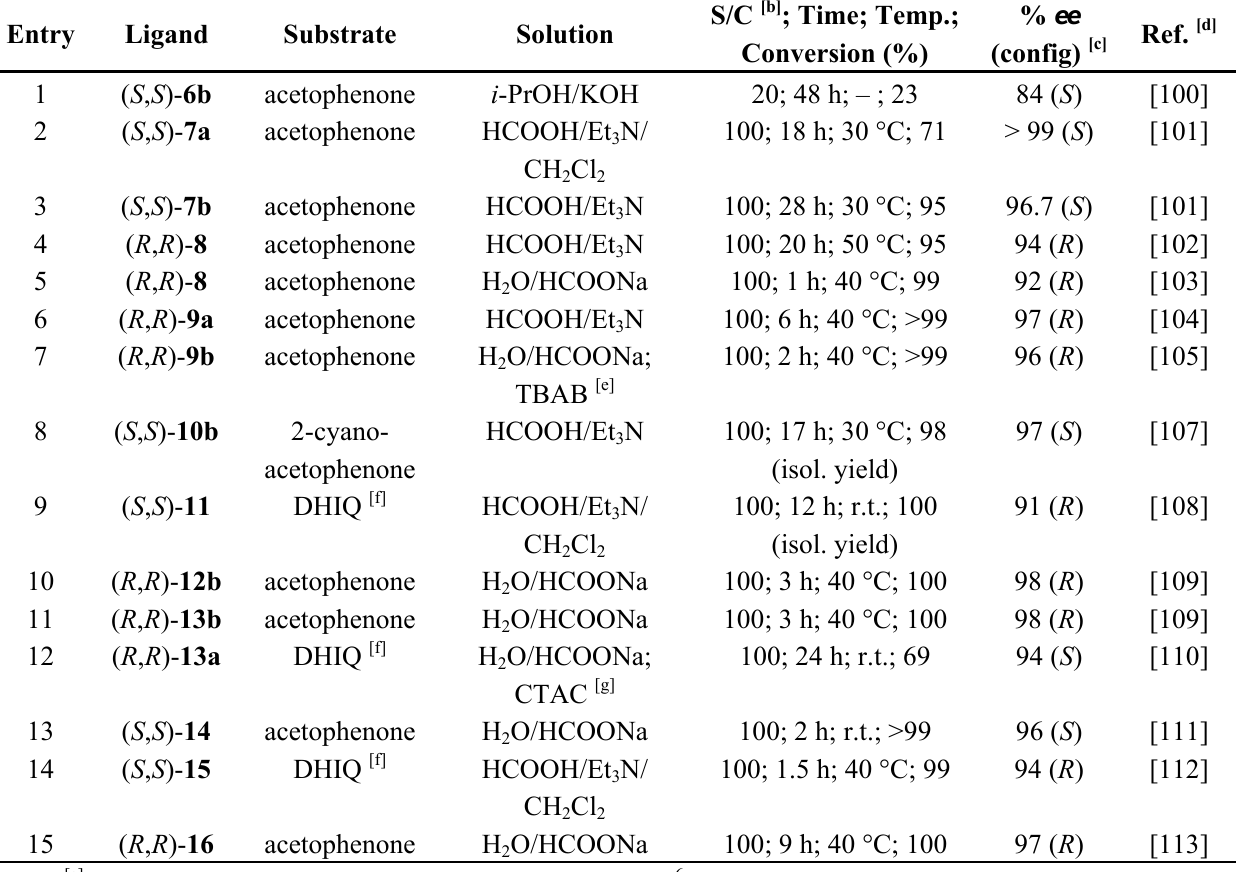
Table 5. ATH of ketones and imines using immobilized derivatives of 1 [a]